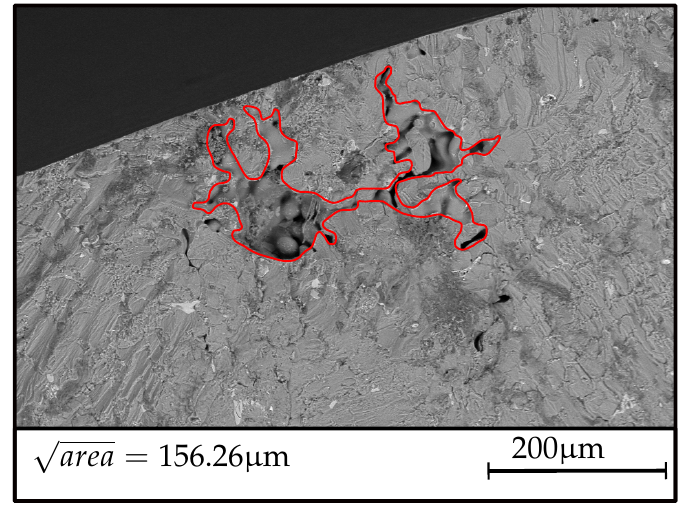
Figure 10. Representative fracture initiating defect at specimen geometry